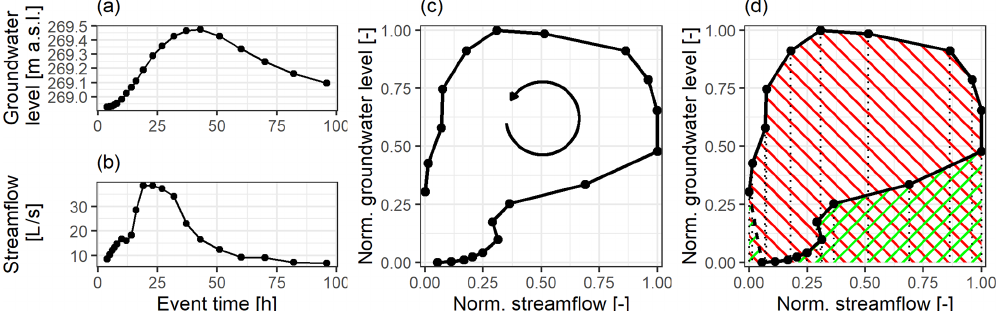
Figure B1. Example of the hysteresis index calculation: (a) and (b) show original groundwater and streamflow time series, respectively; (c) shows the anticlockwise hysteresis loop of the normalized time series from (a) and (b) ; (c) shows the positive and negative area contributions to the hysteresis index in a green and red pattern, respectively. Hysteresis index is − 0 .